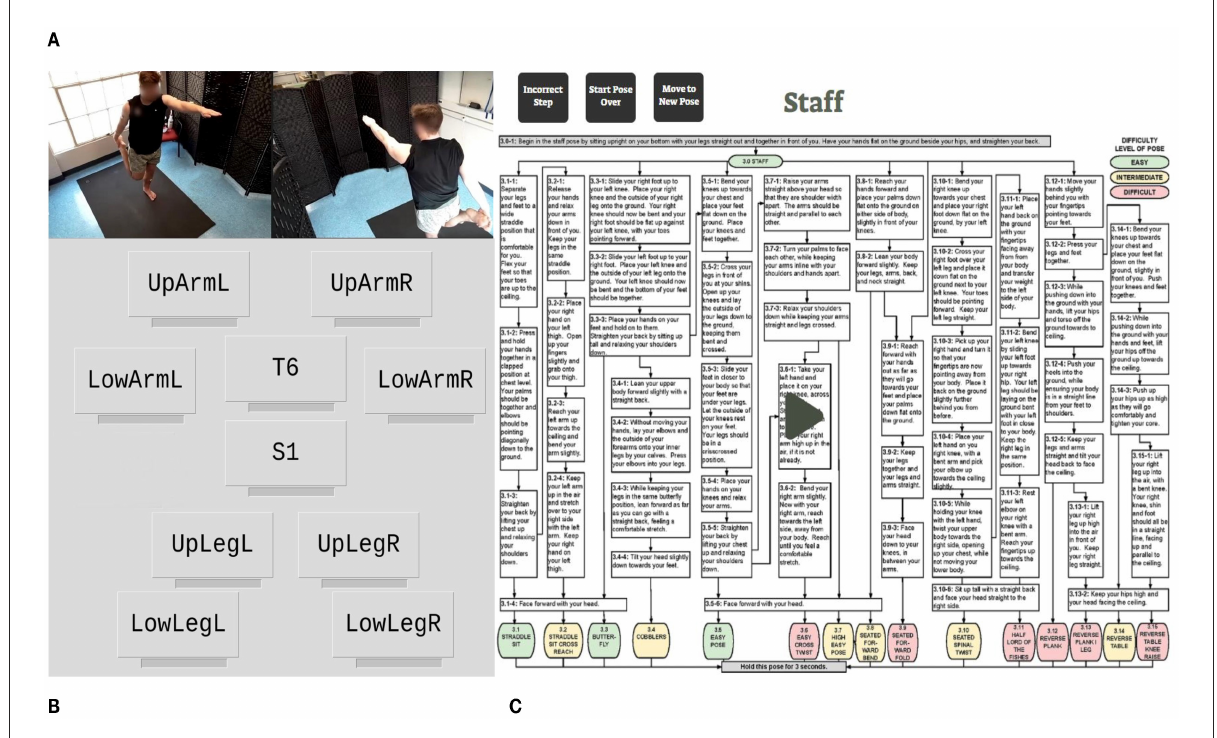
FIGURE2 A custom web-based application developed for the feedback system. (A) Two camera views (front and back). (B) Interface for sending vibrotactile feedback. (C) Interface for sending verbal instructions and